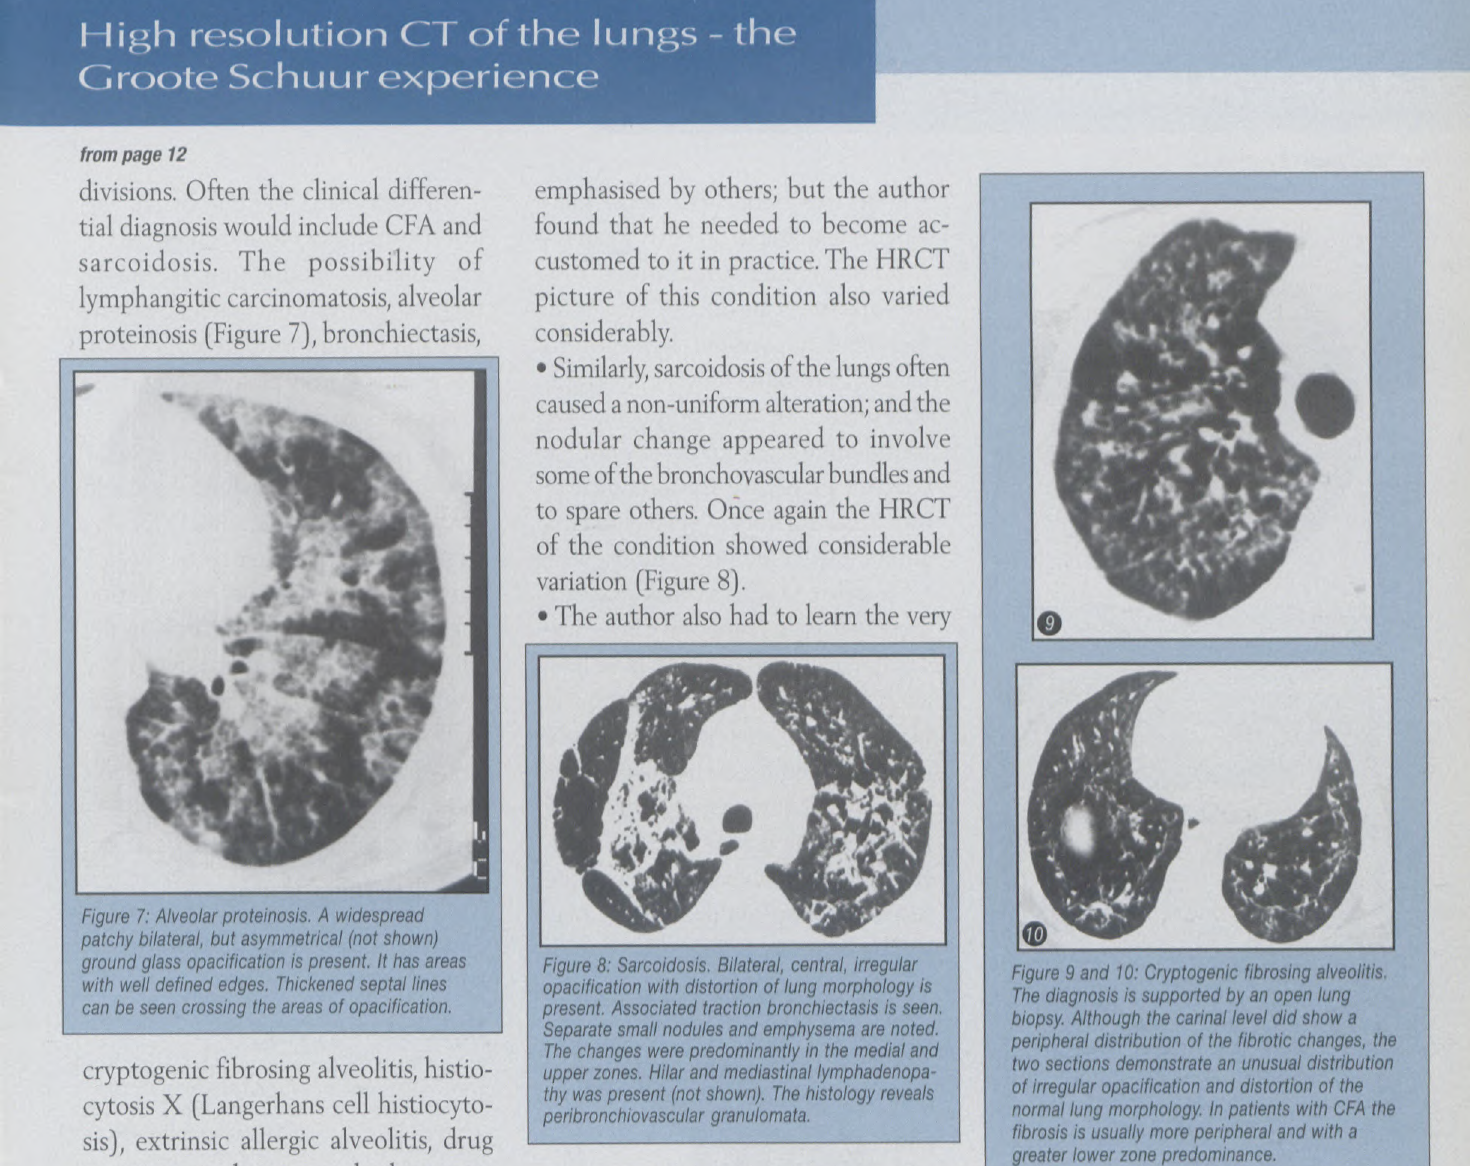
Figure 9 and 10: Cryptogenic fibrosing alveolitis. The diagnosis is supported by an open lung biopsy. Although the carinallevel did show a peripheral distribution of the fibrotic changes, the two sections demonstrate an unusual distribution of irregular opacification and distortion of the normal lung morphology. In patients with CFA the fibrosis is usually more peripheral and with a greater lower zone